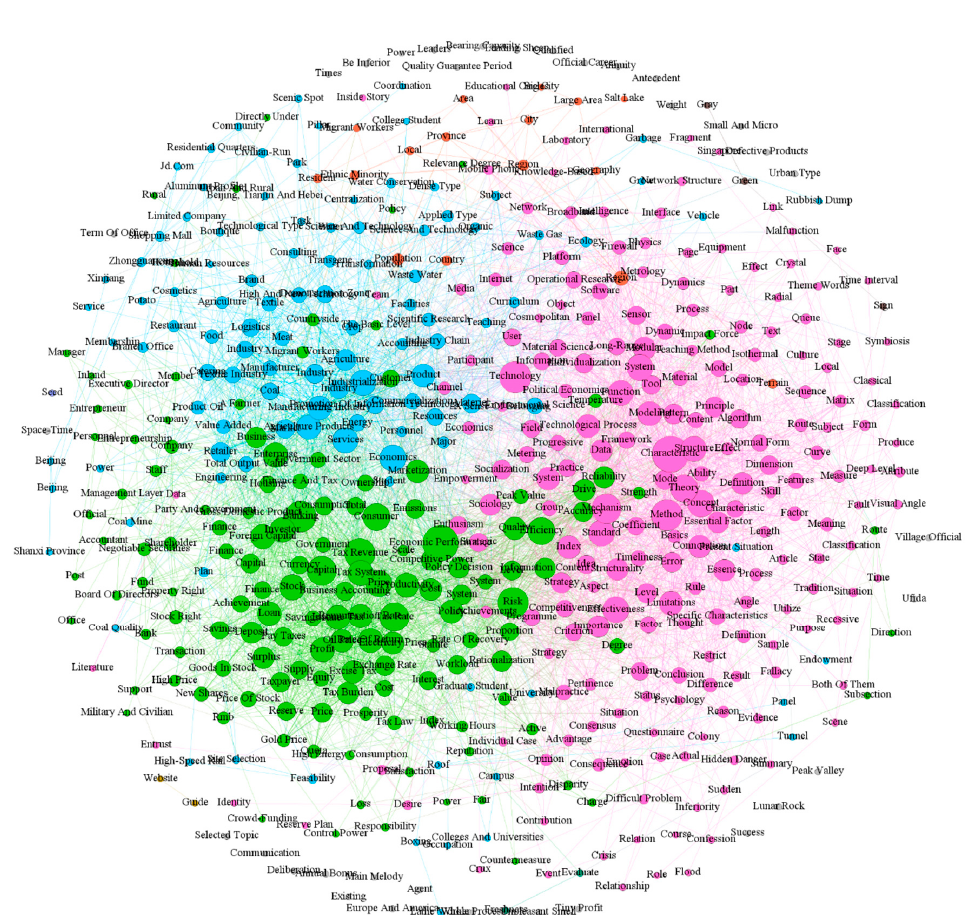
Figure 1. Reserved knowledge network of the economic and management college of a university. At α = 0.1 and after applying Formulas (6)–(8) to the above corpus materials to extract high- frequency topic words, 18 topic words were obtained. The weights 𝑡𝑓𝑖𝑑𝑓 (cid:3036) ′ of each topic word in the